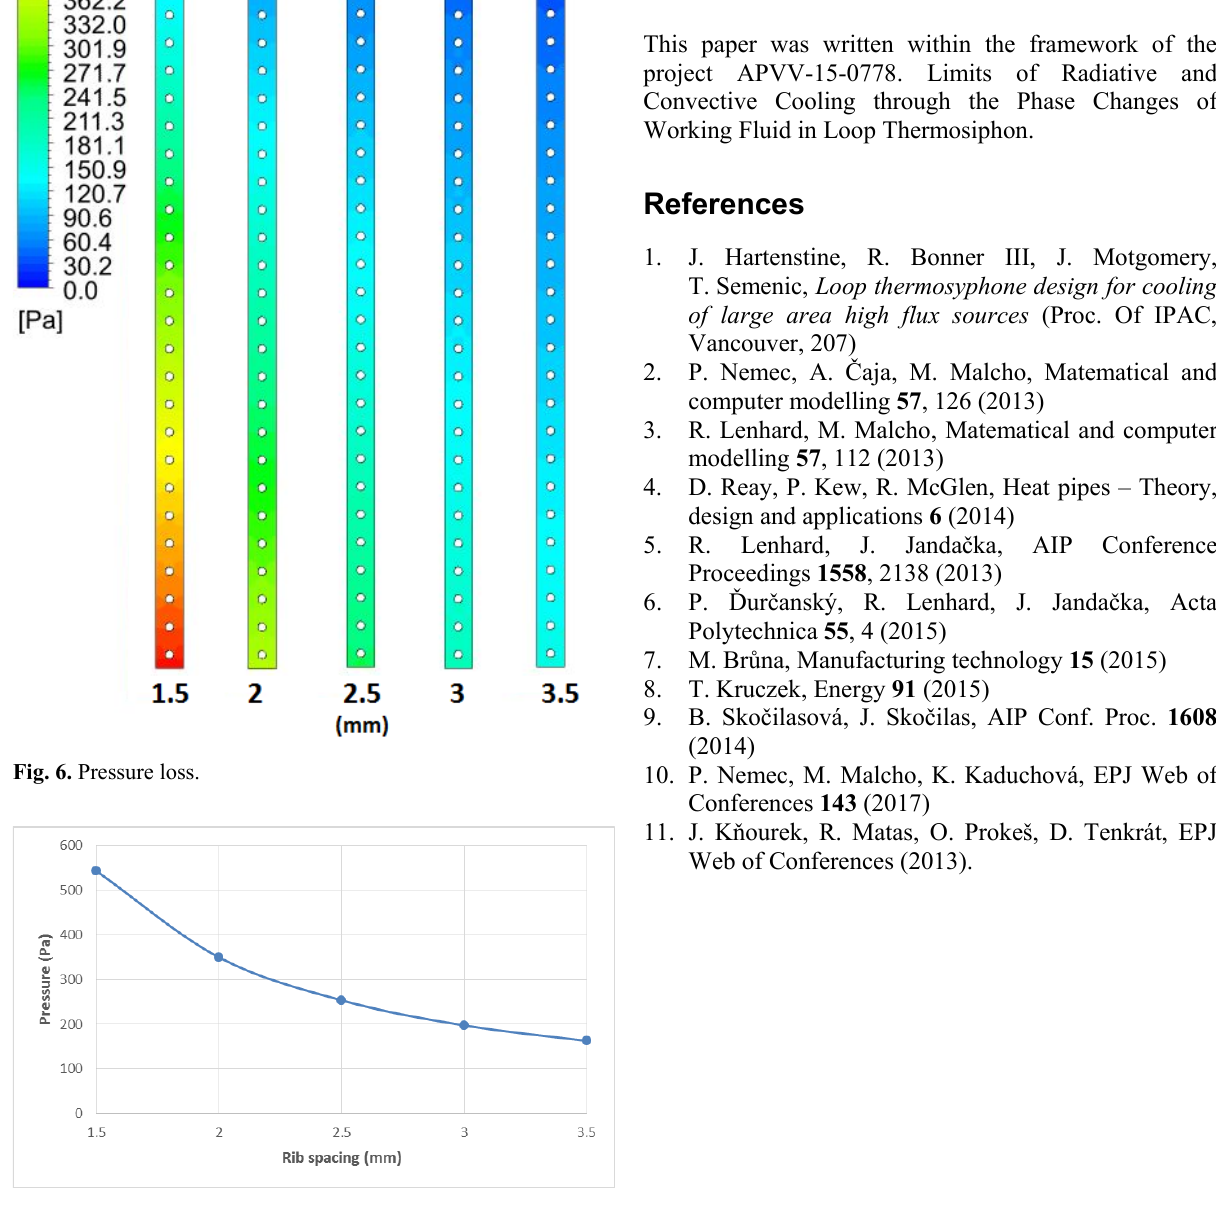
Fig. 7. Pressure loss drop dependance on distance of